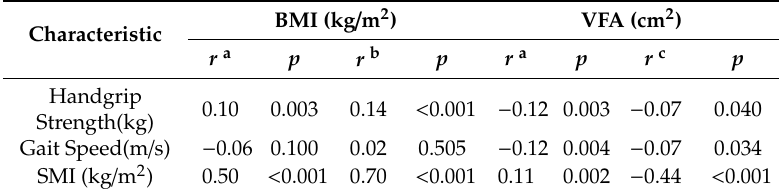
Table 2. Correlations among BMI, visceral fat area (VFA) and muscle health